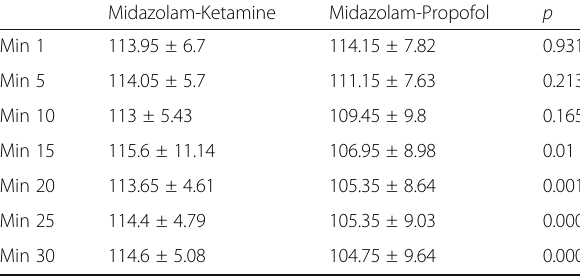
Table 4 Systolic blood pressure